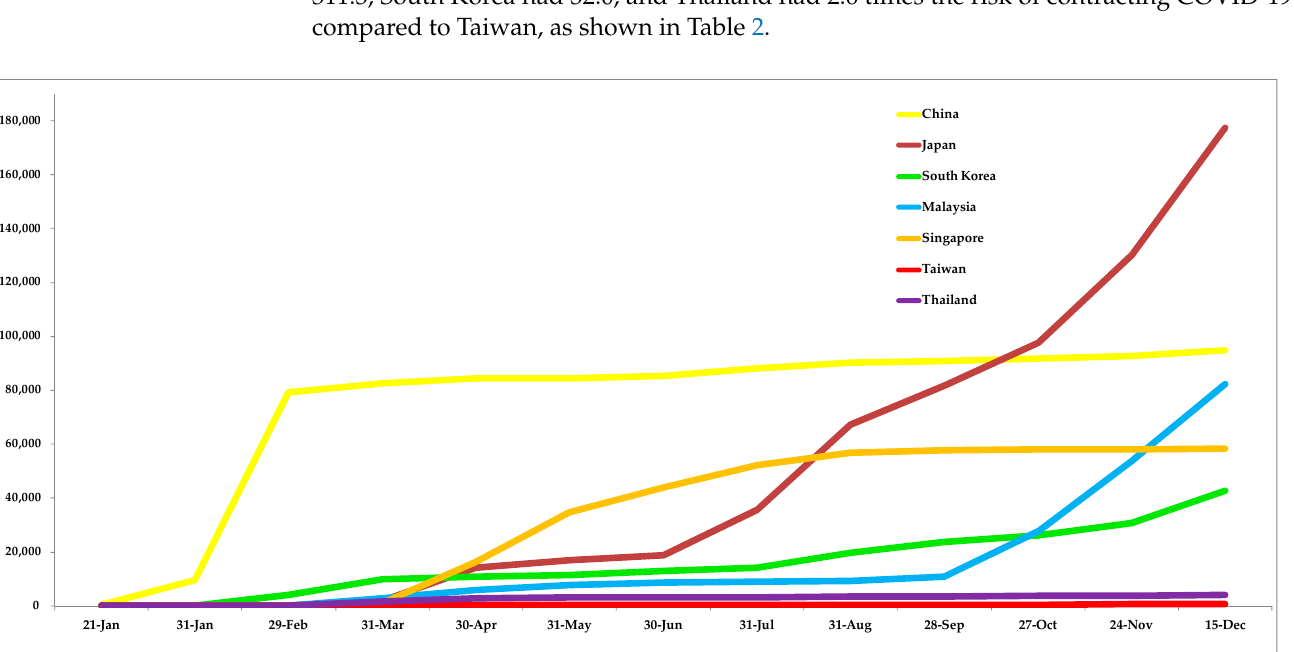
* Population data , COVID-19 confirmed cases, deaths, and testing data taken from reported cases and deaths by country, territory, or conveyance [8].